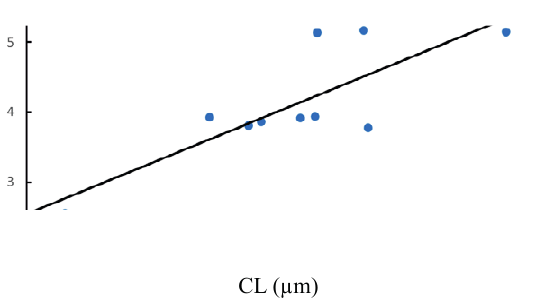
Figure 9. Diagram of the linear regression relationship between genome size and chromosome length for four species (S7-S10) with the same chromosome number (2 n = 2 x =